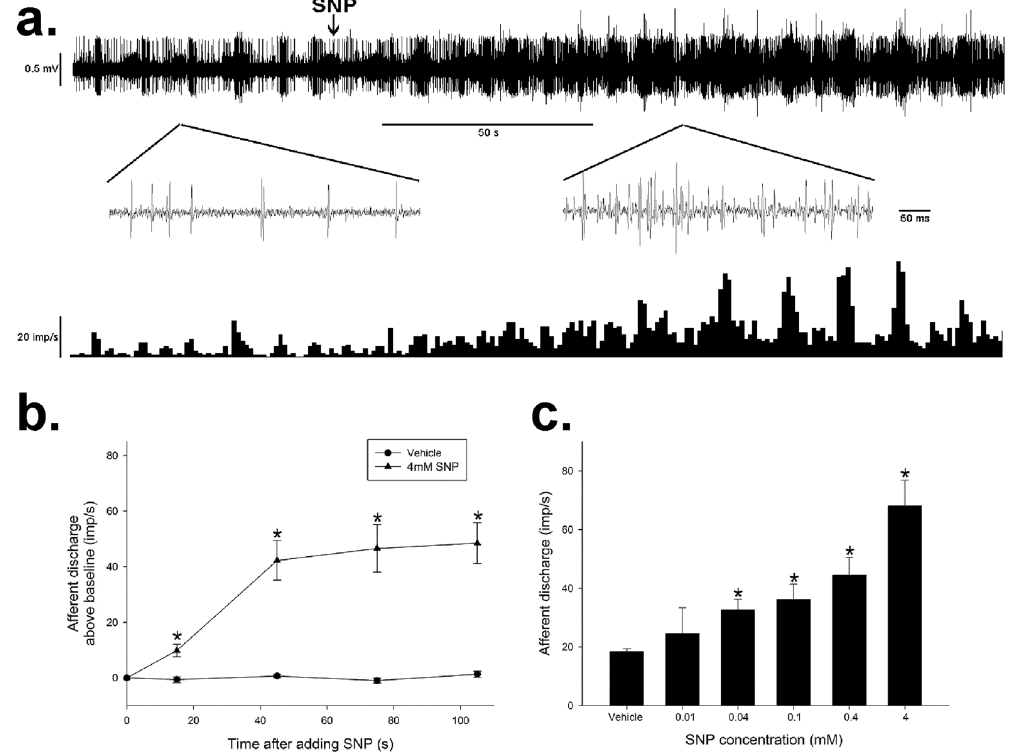
Figure 2. SNP increased the jejunal afferent spontaneous discharge in rats in a dose-dependent manner. ( a ) Raw recording of whole nerve activity before and after bath application of SNP (upper trace) and the number of nerve discharge in 3 s (lower trace). The inserts of the upper trace denote an expanded time-base to show the afferent spikes. The arrows indicate the application of SNP (4 mM) at the serosal side of the intestinal segment. ( b ) Time course of the excitatory effect of SNP (4 mM) on the spontaneous discharge rate of afferent nerve. The frequency of the afferent discharge increases at 20 s, reaches and maintains at plateau 50 s later. n = 6 in each group, * P < 0.05 vs vehicle, Students’ t -test. ( c ) Dose-response character for the excitatory effect of SNP (0.01–4 mM) on spontaneous discharge rate. The data shown in the columns are the frequencies of afferent discharge at 105 s following SNP or vehicle administration. n = 6 in each group, * P < 0.05 vs vehicle, Students’ t